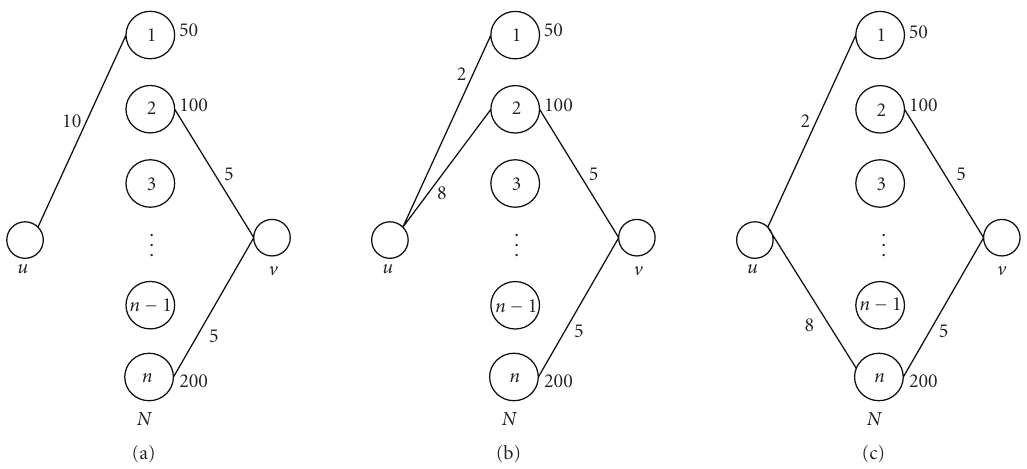
Figure 4: Interest similarity between nodes. The number of data items in 1, 2, and n is 50, 100, and 200, respectively. (a) No common visited nodes (di ff erent interests), (b) u and v have visited node 2 (100 data items) with 8 and 5 times, respectively (a certain level of similar interests), (c) u and v have visited node n (200 data items) with 8 and 5 times, respectively (falls in